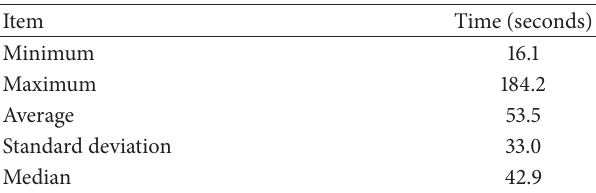
Figure 13: Mean times in seconds for 10 successful logins. Table 2: Statistics of successful login